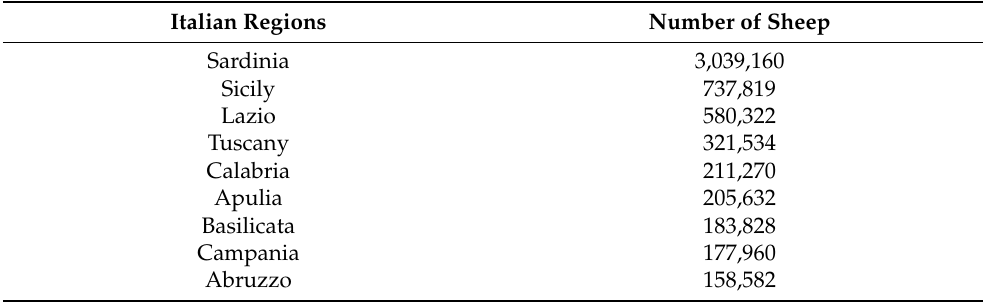
Table 3. Consistency of the Italian sheep population divided by region. (Source processing